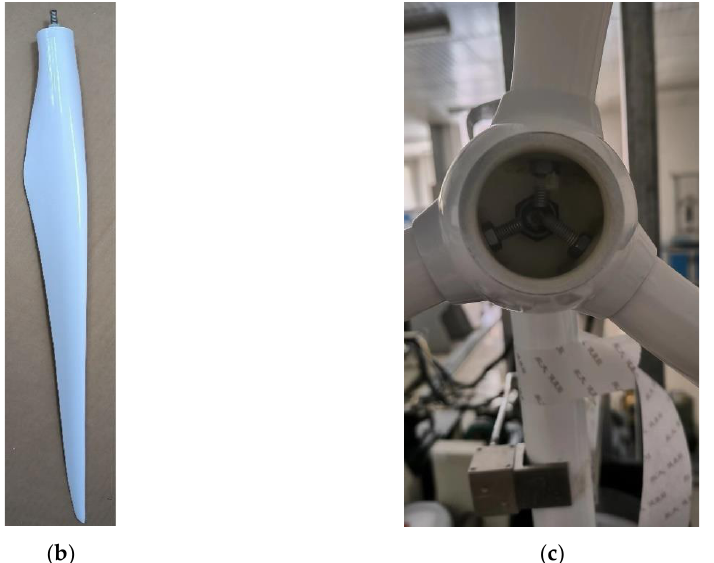
Figure 4. The OWT model: ( a ) the OWT model and the control system; ( b ) the geometry of the blades; and ( c ) the nacelle. Table 2. Parameters of the DAQ